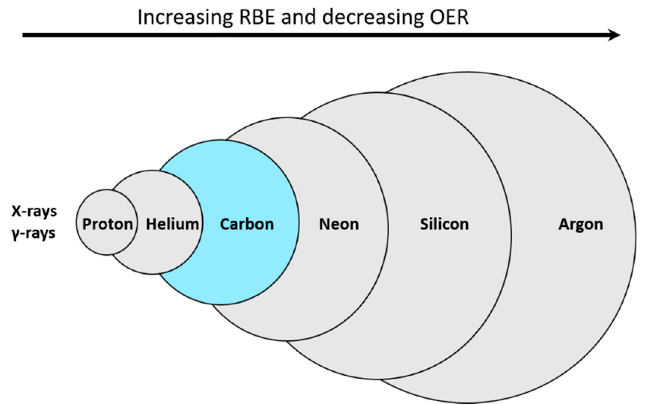
Figure 2. Simplified schematic diagram showing the relationship between atomic mass, relative biological effectiveness (RBE) and oxygen enhancement ratio (OER) for different particles in comparison to photons. The size of each circle represents atomic mass (not drawn to scale).